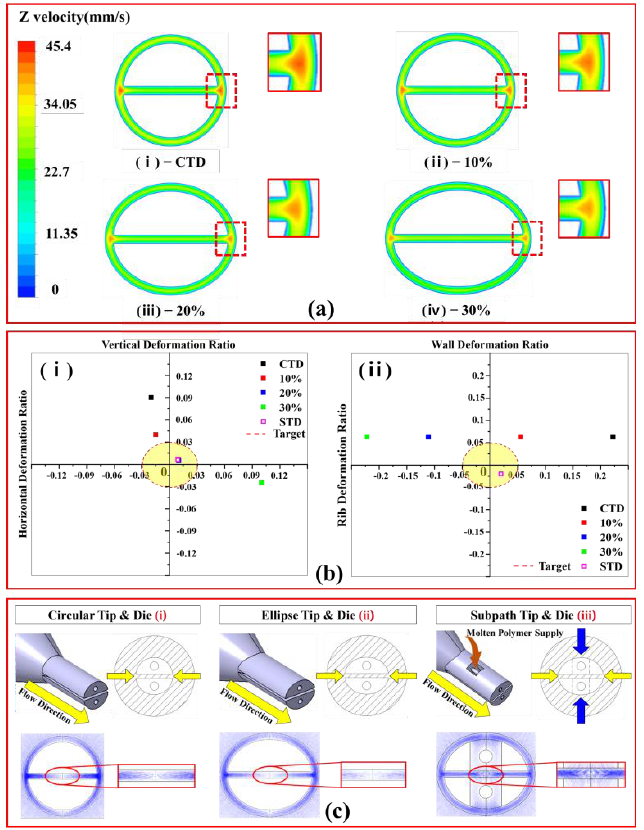
Figure 5. Analysis results using three types of tips and dies: ( a ) Flow velocity contours of various tip and die models; from initial model ( i ) to ( iv ), shape is corrected by 10% to 30% in horizontal direction; ( b ) graph of deformation ratio calculation result for evaluating various tip and die models; and ( c ) schematic diagram of molten polymer supply mechanism for sub path tip and die according to stream line prediction results.